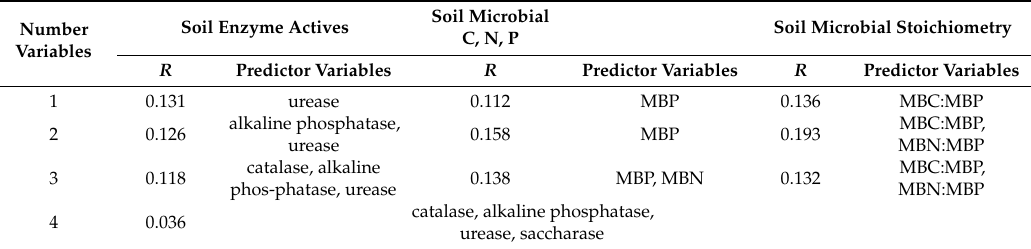
Table 5. Results from the BEST model for each number of predictor